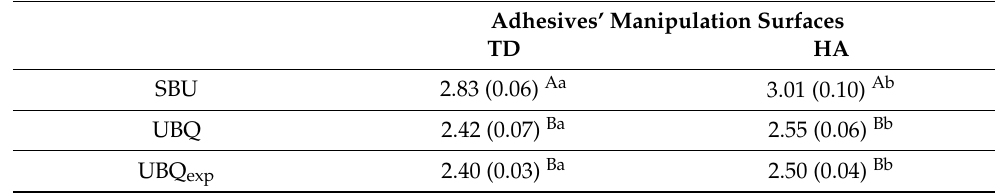
Table 2. Results of the pH values of all three